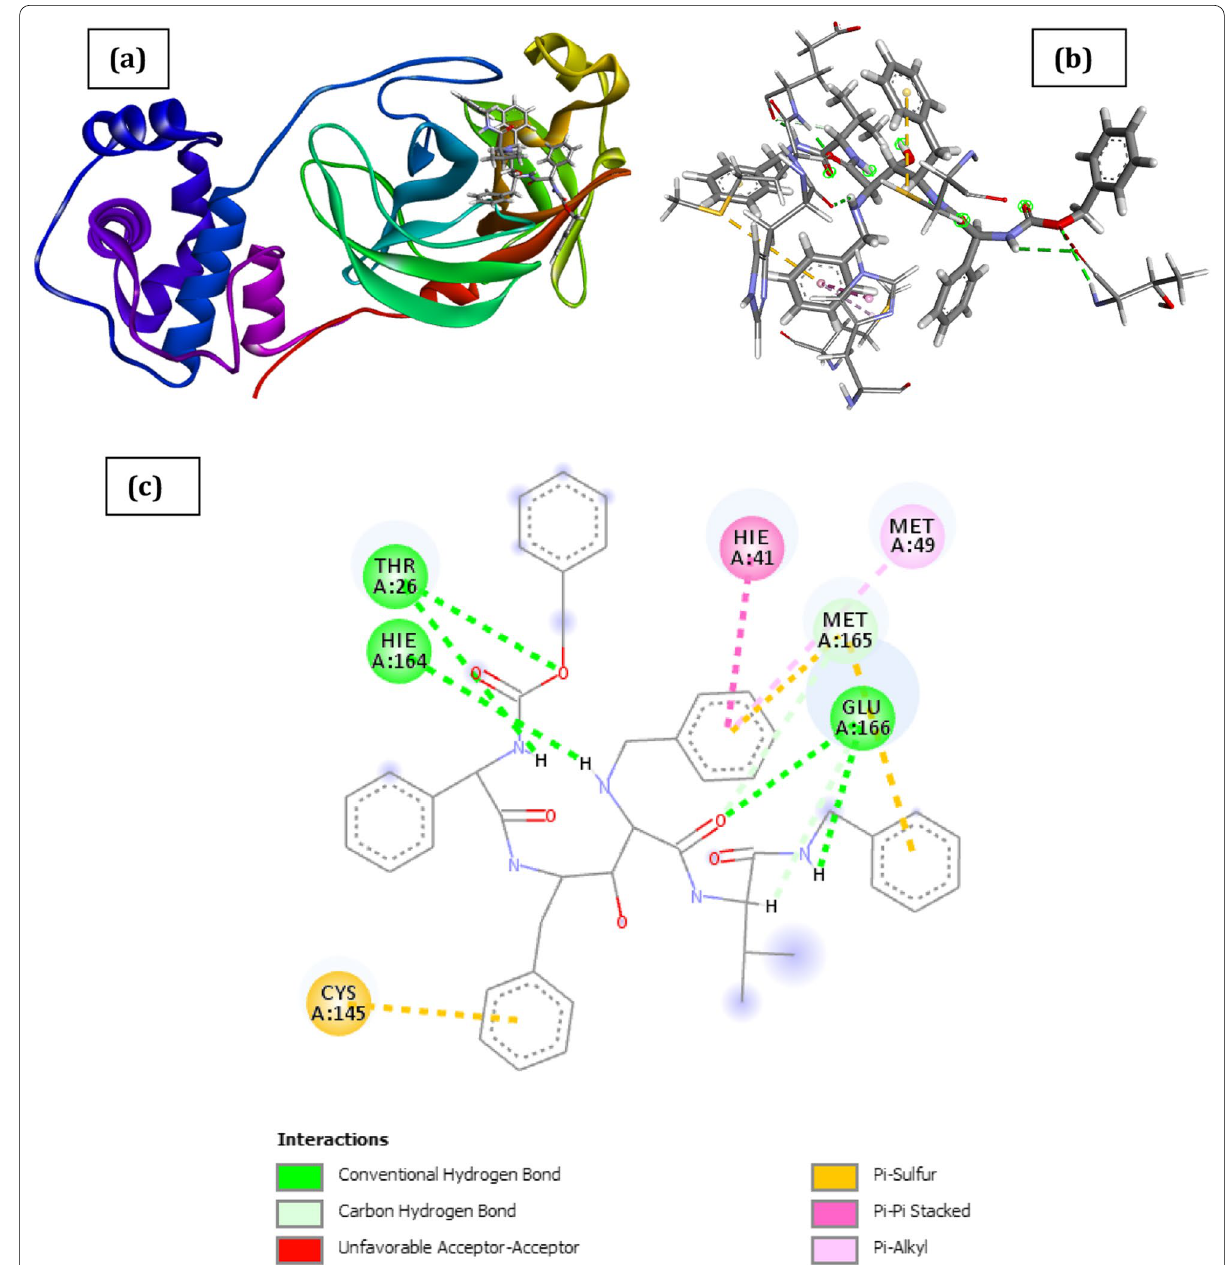
Fig. 5 Docked poses of SARS CoV 2 main protease (PDB ID: 6XBH) with inhibitor with Index number 741 (stick figure) a 3D view of docked pose of SARS CoV 2 Main Protease (PDB ID: 6XBH) with inhibitor with Index number 741; b 3D view of inhibitor with Index number 741 with surrounding amino acids of 6XBH; c 2D view of interaction type of inhibitor with Index number 741 with surrounding amino acids of